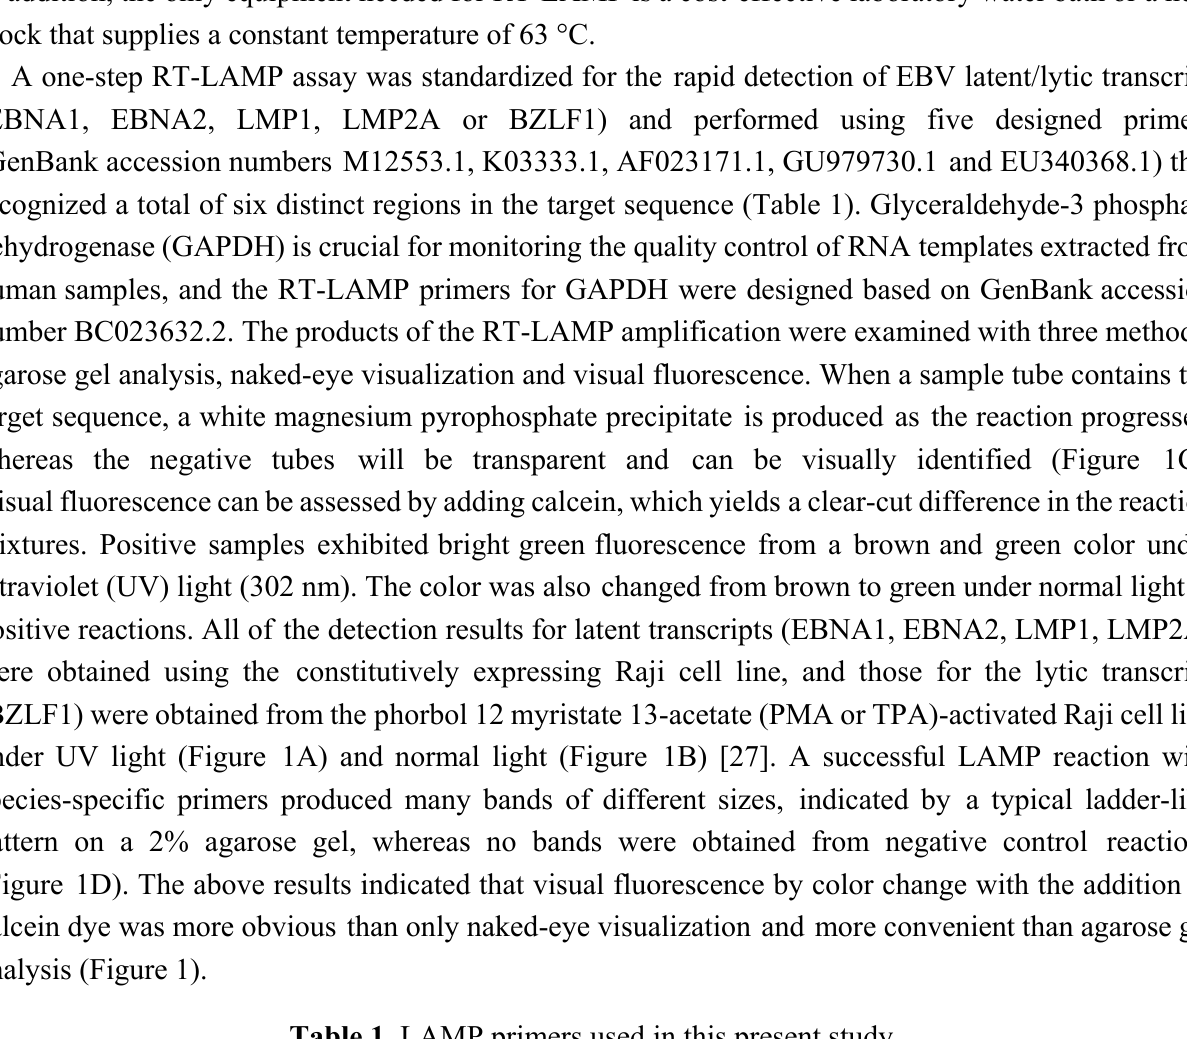
Table 1. LAMP primers used in this present